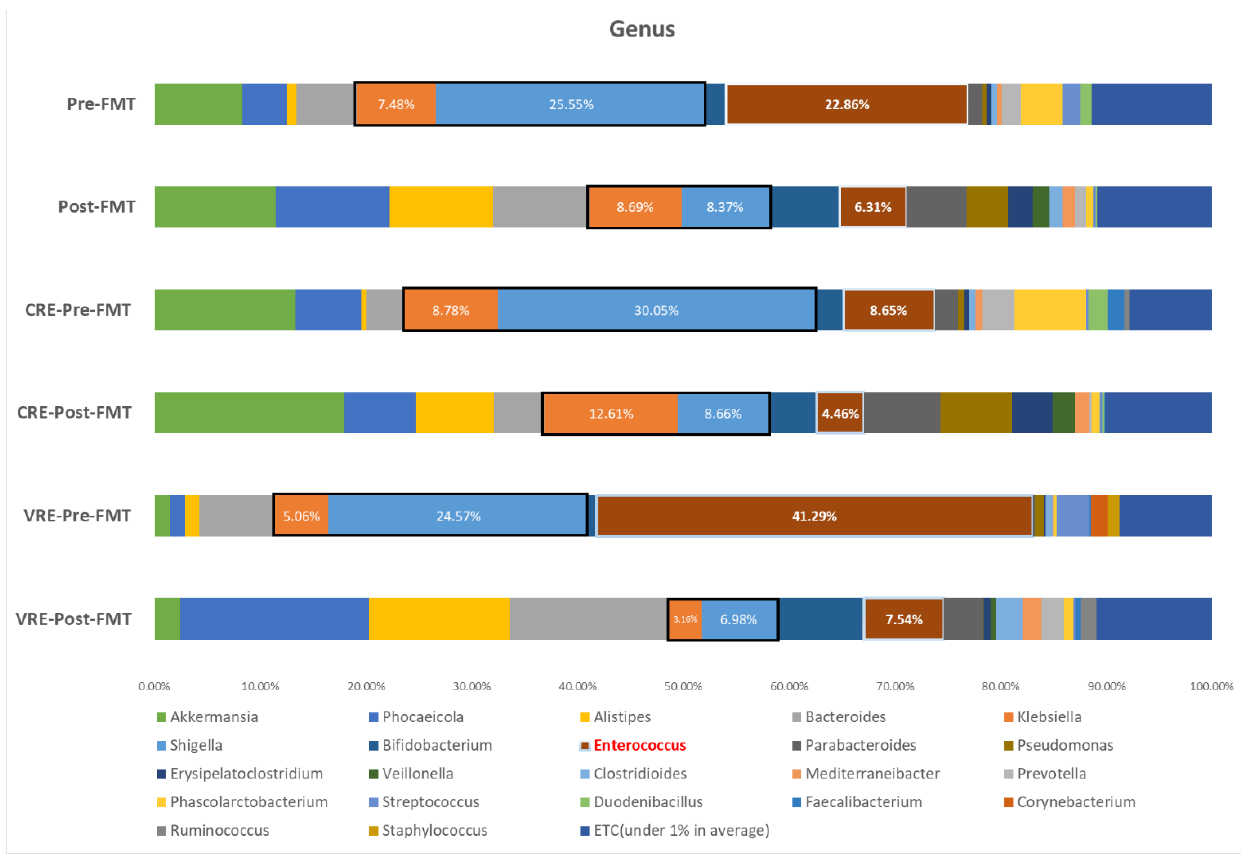
Figure 4. Comparison of abundance according to genus: pre- and post-fecal microbiota transplan- tation (FMT), pre- and post-FMT in patients infected with carbapenem-resistant Enterobacteriaceae (CRE); and pre- and post-FMT in patients infected with vancomycin-resistant enterococci (VRE). Black box indicated Enterobacteriaceae family including Klebsiella and shigella.